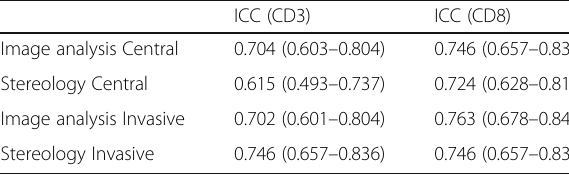
Table 7 Intra-class correlation coefficient for estimates of area fraction Image analysis